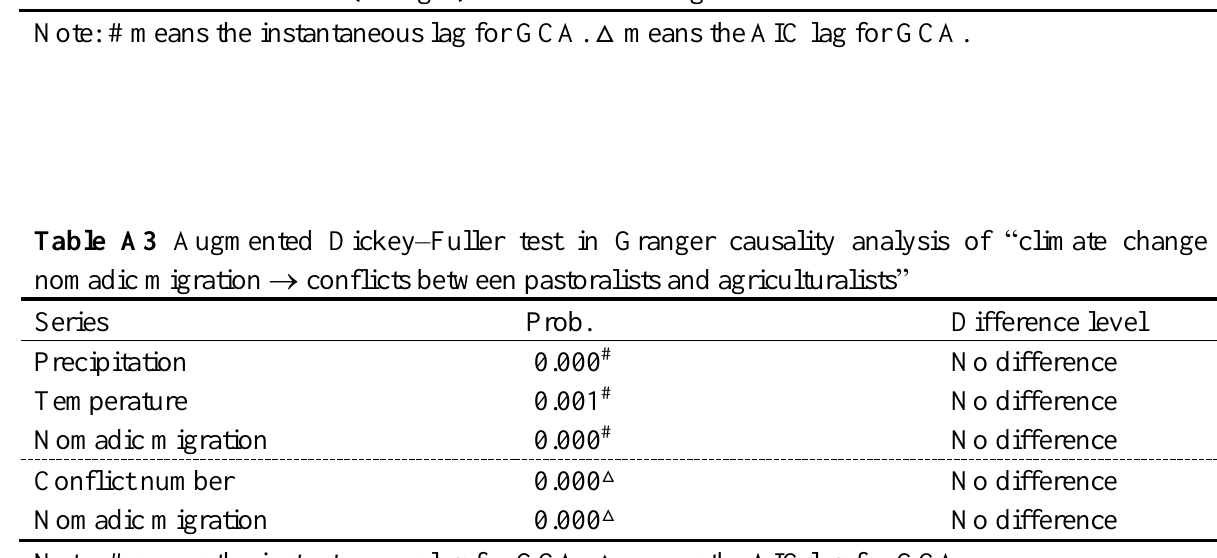
Table A2 Time lag in Granger causality analysis on “climate change  nomadic migration  conflicts between pastoralists and agriculturalists” Null hypothesis Lag Precipitation does not (Granger) cause nomadic migration. 1# Temperature does not (Granger) cause nomadic migration. Nomadic migration does not (Granger) cause conflict number. Conflict number does not (Granger) cause nomadic migration.